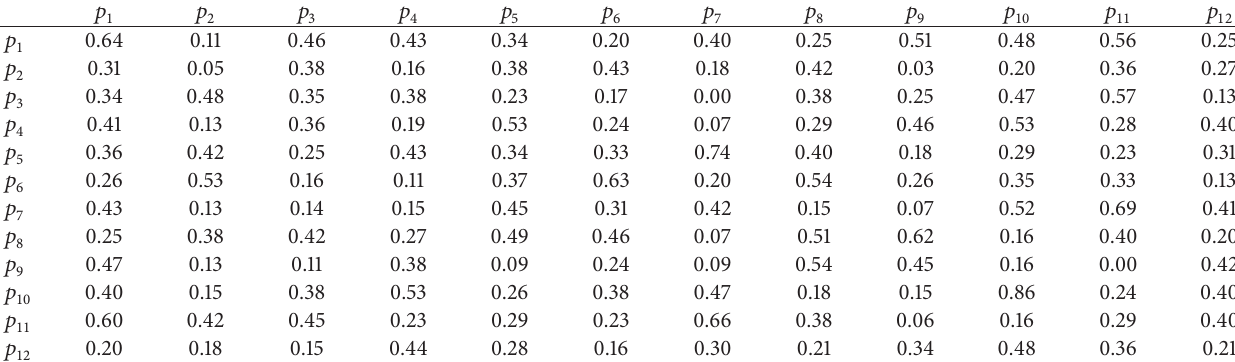
Table 8: Comprehensive values of individual information and collaborative information of candidate units.